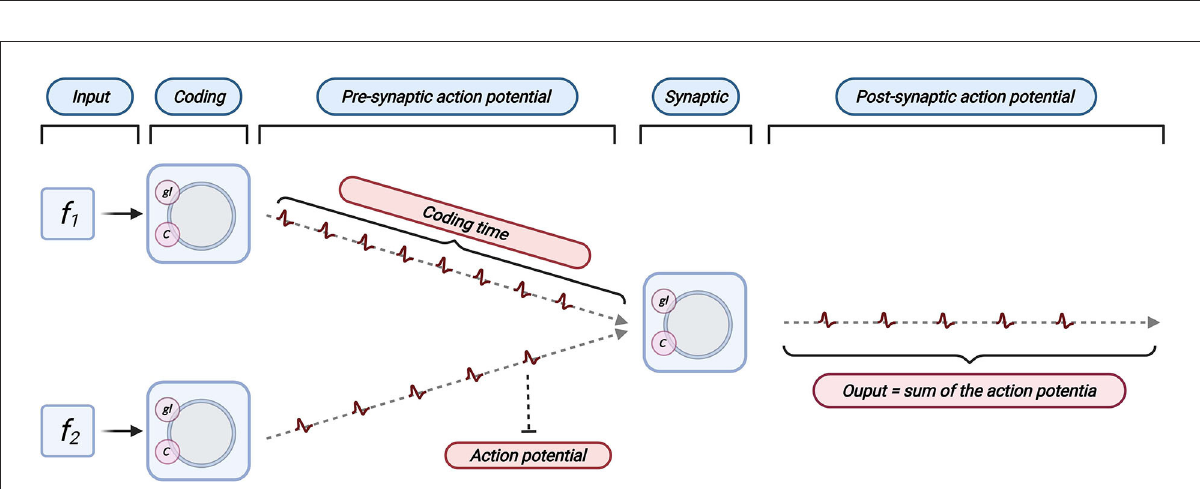
FIGURE6 The structure of the simulation. The whole structure consists of three neurons, two of which are used for information coding and serve as presynaptic neurons; the third LIF neuron is used to process the input of the first two neurons and produce an output spike train. There are two synaptic structures in this